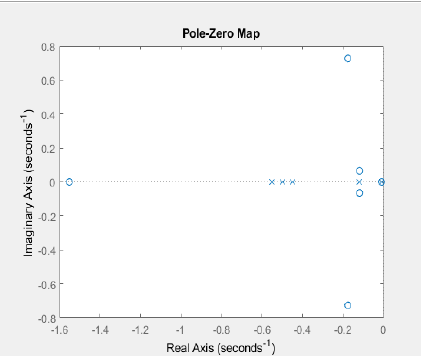
Figure 37. Plot of poles and zeros of seven state variables.